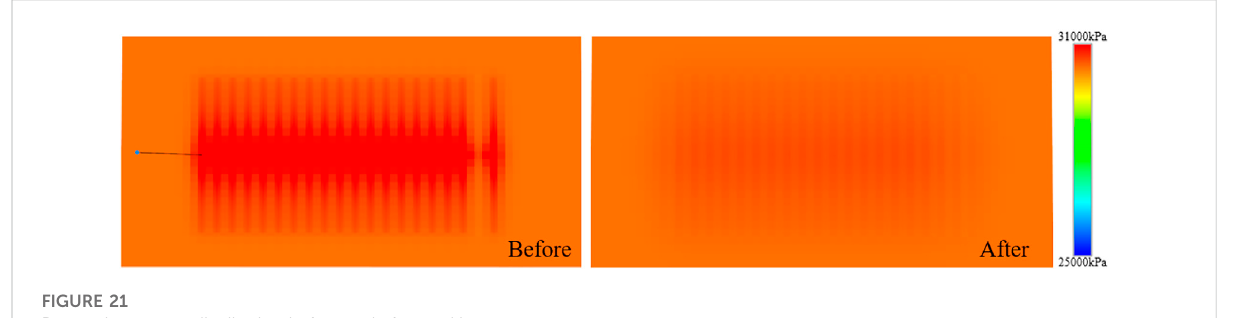
FIGURE 21 Reservoir pressure distribution before and after